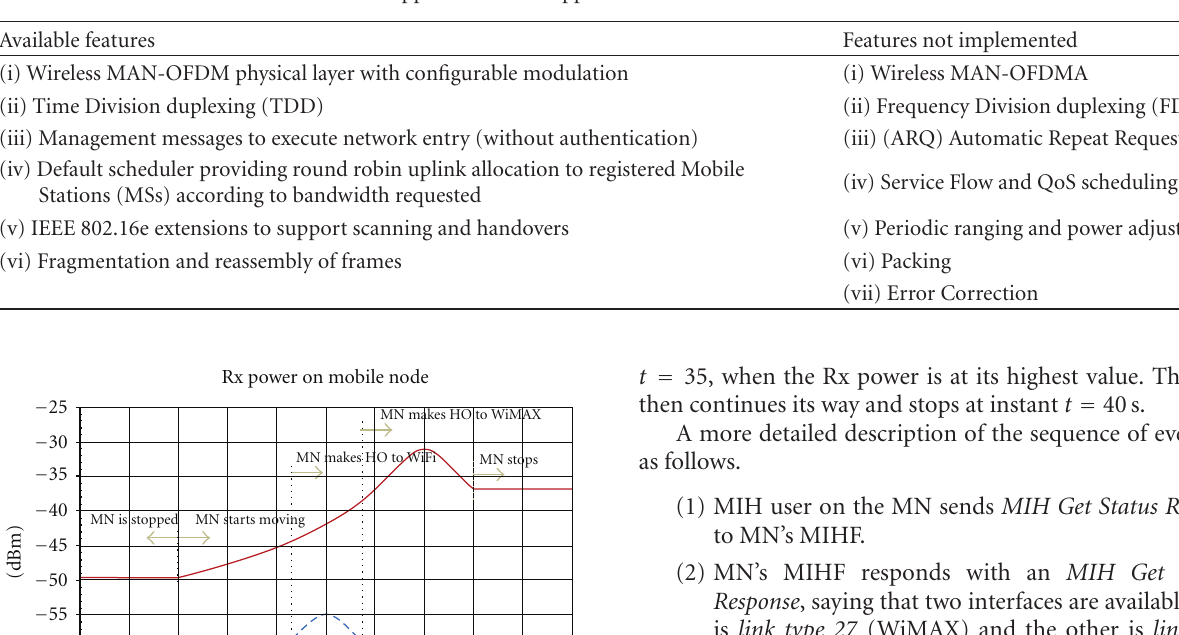
Table 1: Supported and unsupported features in ns-2 WiMAX module.